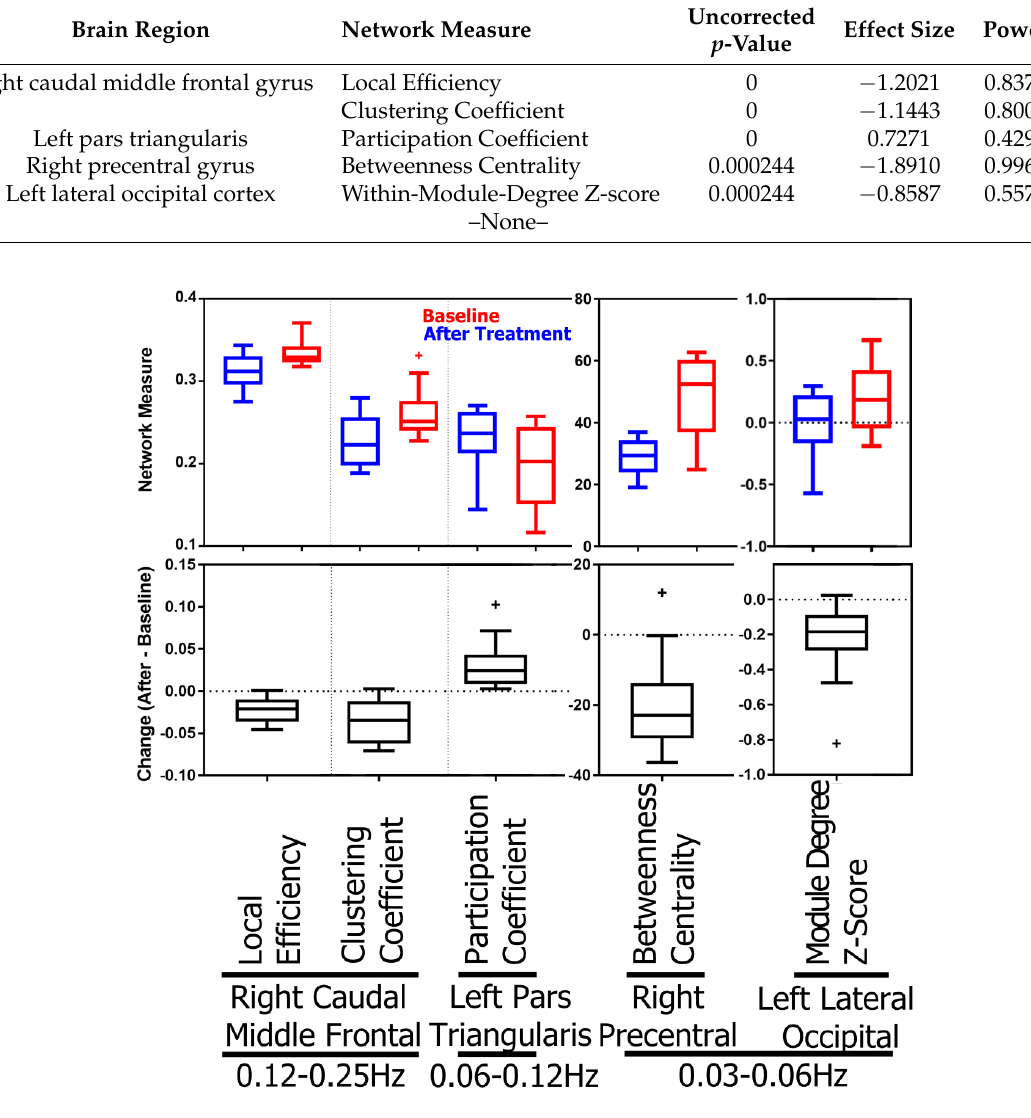
Figure 3. Boxplots for AUCs of topological brain network measures with significant change. The top panel shows the distributions of AUCs before and after the treatment, and the bottom panel shows the distributions of paired AUC changes. Based on the finding of local efficiency and clustering coefficient change of right caudal middle frontal gyrus in the 0.12–0.25 Hz network, other regions in the same network are also investigated with a lower criteria ( p -value ≤ 0.05). Results, summarized in Table 4, show both decreased clustering coefficient and decreased local efficiency in bilateral caudal middle frontal gyrus, rostral middle frontal gyrus, superior temporal gyrus, left pars triangularis, putamen, and right superior frontal gyrus. No region is found with either increased clustering coefficient or local